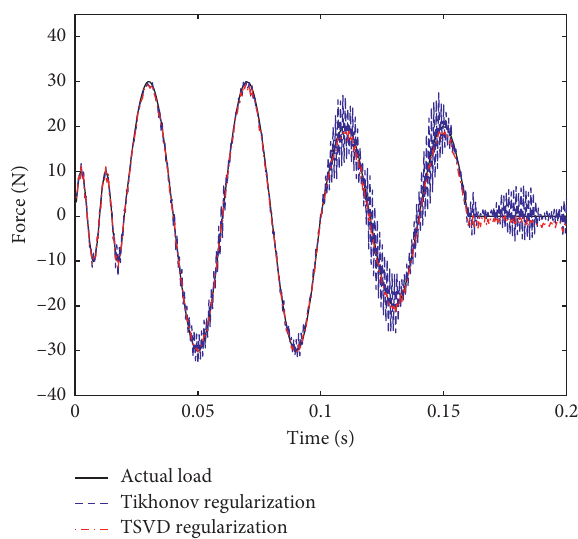
Figure 6: Identification results of mixed sinusoidal loads under 5% noise.